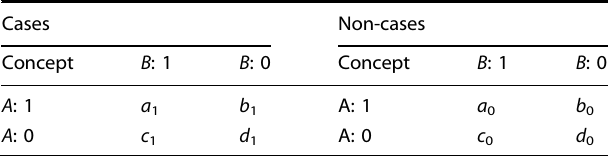
Table 10. Contingency tables of structured-unstructured concept pairs A-B , for case and non-case